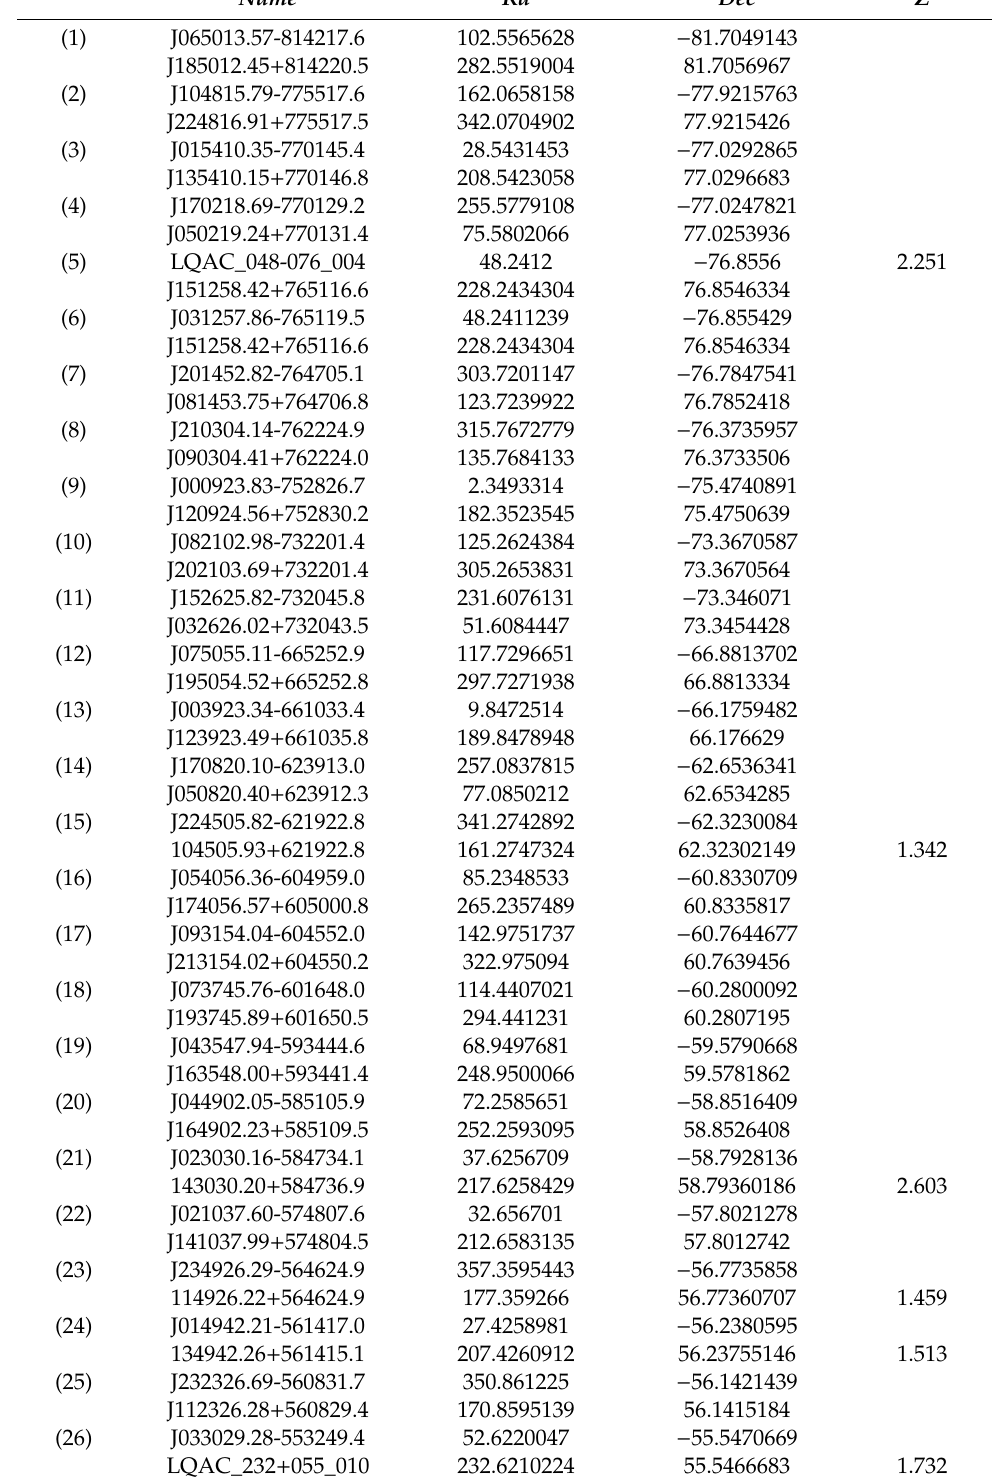
Table A17. Pairs of opposite quasars from the KQCG catalog for the lens e ff ect (abbr. in name: L_ = LAMOST_). Accuracy is of 0.001 ◦ for ra and dec . Redshift z is given when available, although is not essential